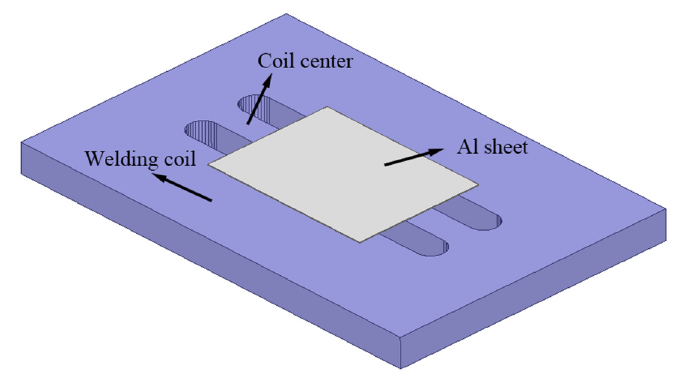
Figure 5. Three-dimensional electromagnetic field simulation model of MPW.